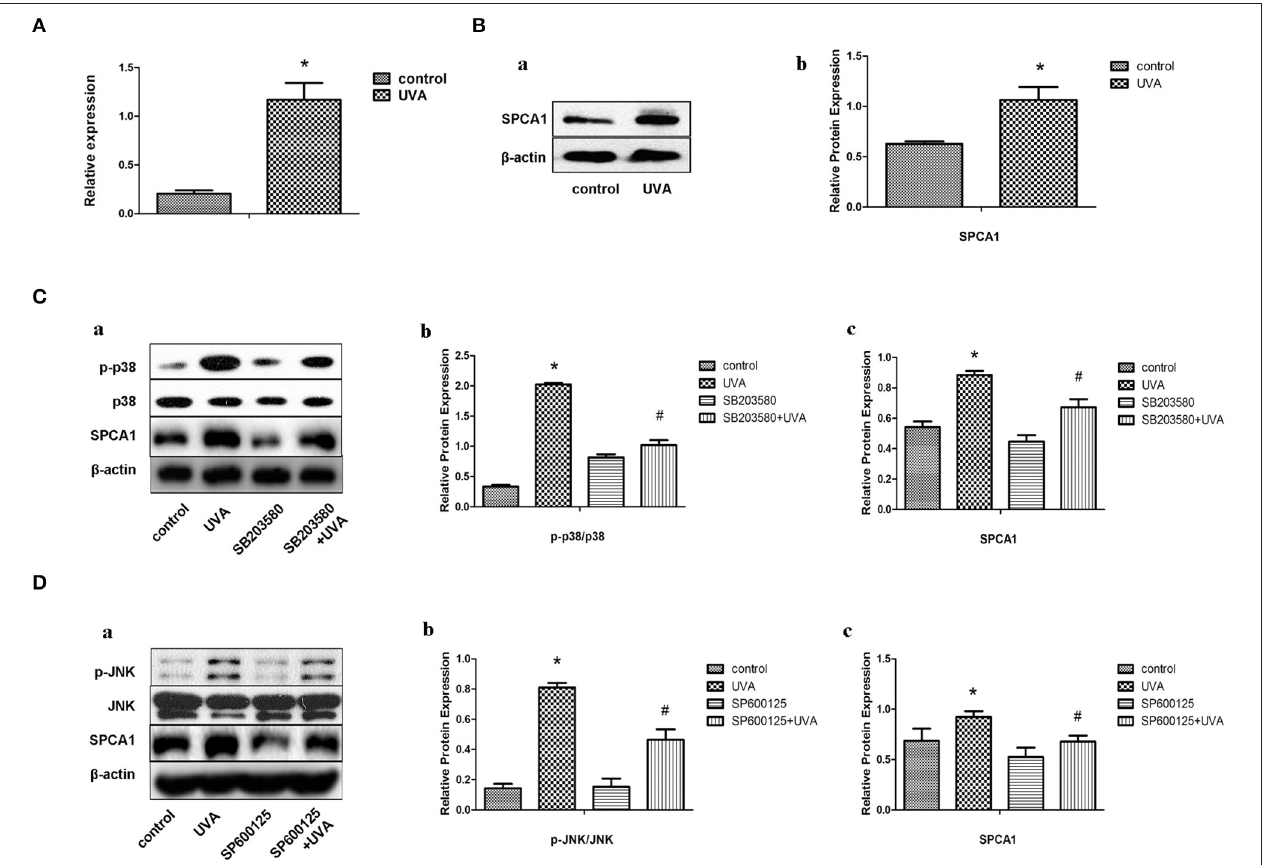
FIGURE 1 | UVA irradiation increases the expression of SPCA1 by activating the MAPK pathway. (A) SPCA1 mRNA expression in control and UVA-irradiated HDFs, as determined by real-time PCR. Each sample was analyzed in triplicate. Data are shown as the mean of three independent experiments. * P < 0.05 vs. control. (B) (a) SPCA1 protein expression in control and UVA-irradiated HDFs, as determined by Western blot analysis. Images are representative of three independent experiments. (b) Bar graphs show quantitative analysis of scanning densitometric values of SPCA1 as ratios to β -actin, which was used as a loading control. Data are representative of three independent experiments. * P < 0.05 vs. control. (C,D) Effects of SB203580 and SP600125 (inhibiter of p38 and JNK) on UVA-induced SPCA1 protein expression and phosphorylation of p38 and JNK as determined by Western blot analysis. Control and UVA-irradiated HDFs were treated with or without 10 µ M SB203580 and SP600125, respectively. Images are representative of three independent experiments. (b,c) Bar graphs show quantitative analysis of scanning densitometric values of SPCA1 as ratios to β -actin and phospho-JNK, p38 proteins as ratios to their total JNK, and p38, respectively. Data are representative of three independent experiments. * P < 0.05 vs. control; # P < 0.05 vs.